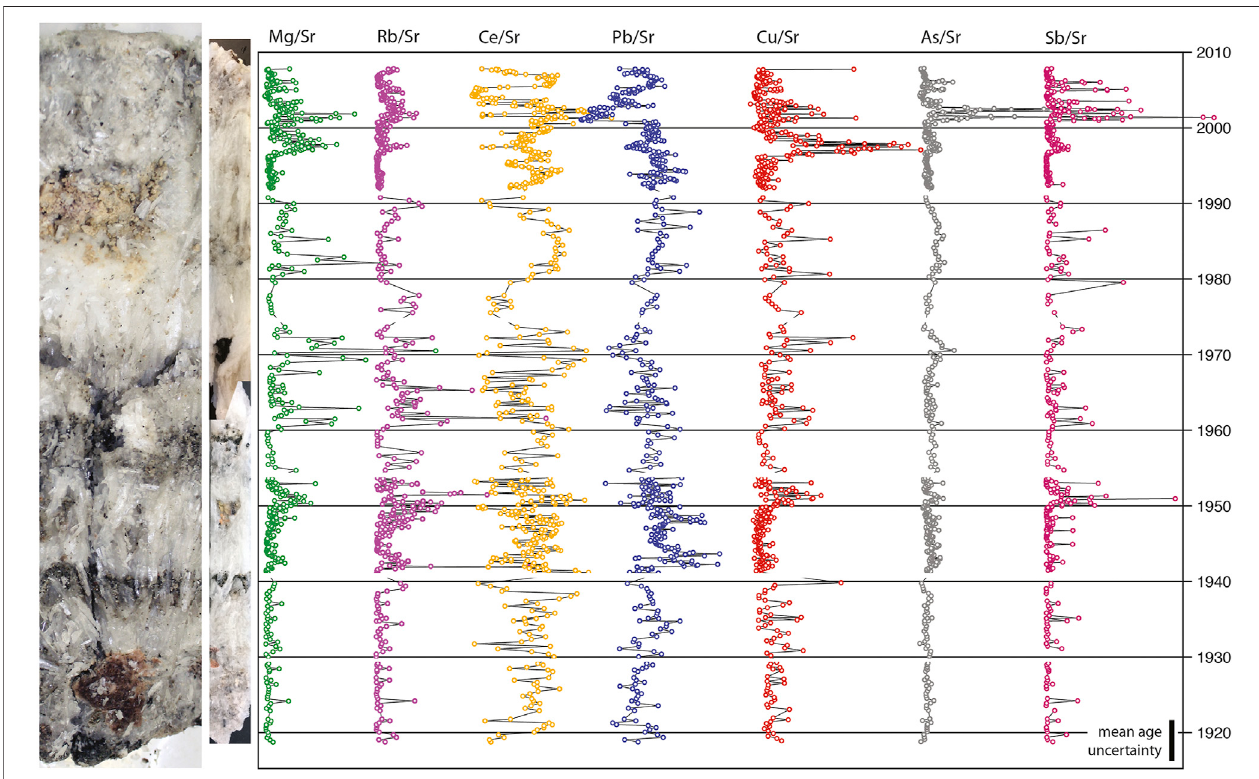
FIGURE 8 | Compositional timeseries for selected elements along the gypsum section shown on the left .